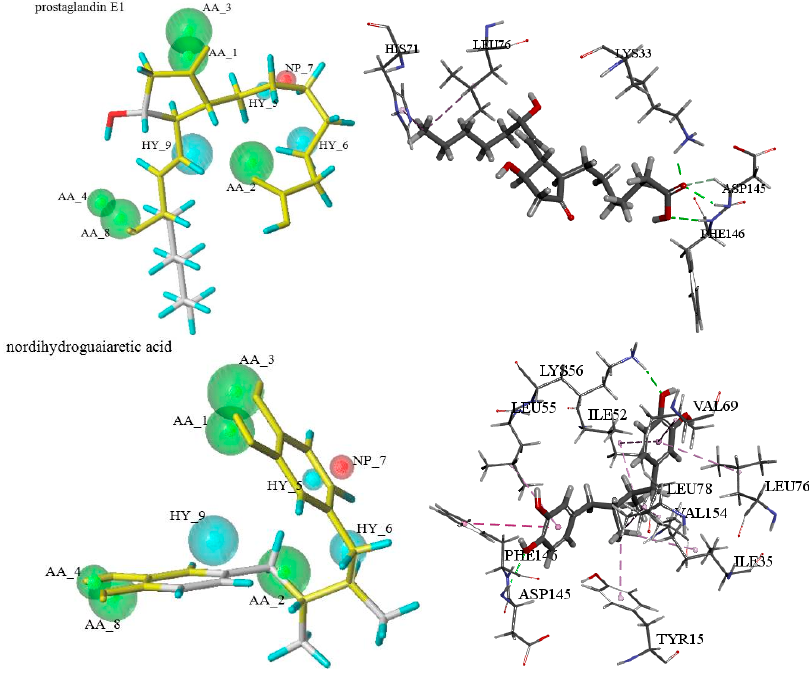
Figure 5. Pharmacophore mapping results and molecular docking results of prostaglandin E1 and nordihydroguaiaretic acid.